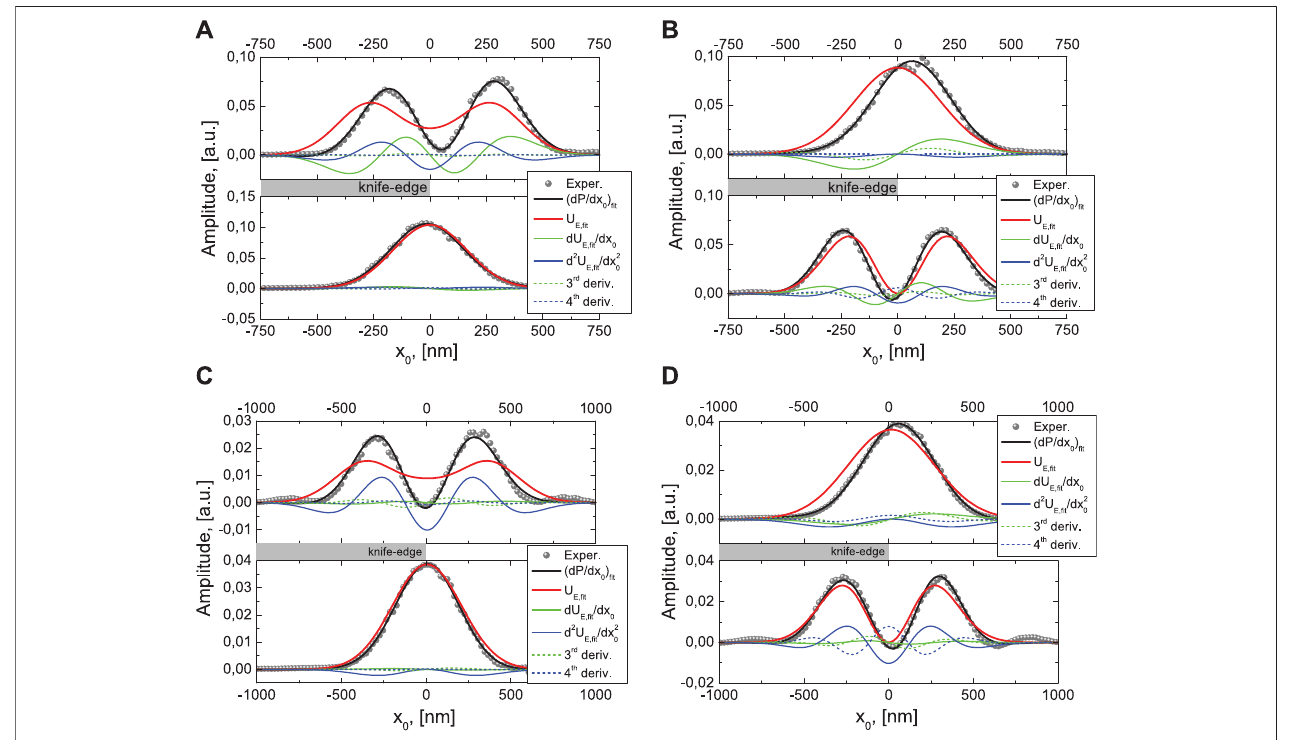
FIGURE 8 | Depiction of the adapted knife-edge method for linear constituents of tightly focused radially (A,C) and azimuthally (B,D) polarized beams. The derivatives of the experimentally measured photocurrents (gray circles) and the fi tted curve (black) with the beam pro fi le (red) are shown together with its fi rst four derivatives at λ (cid:1) 535nm (A,B) and λ (cid:1) 700nm (C,D) . The states of polarization are s ( fi rst row) and p (second